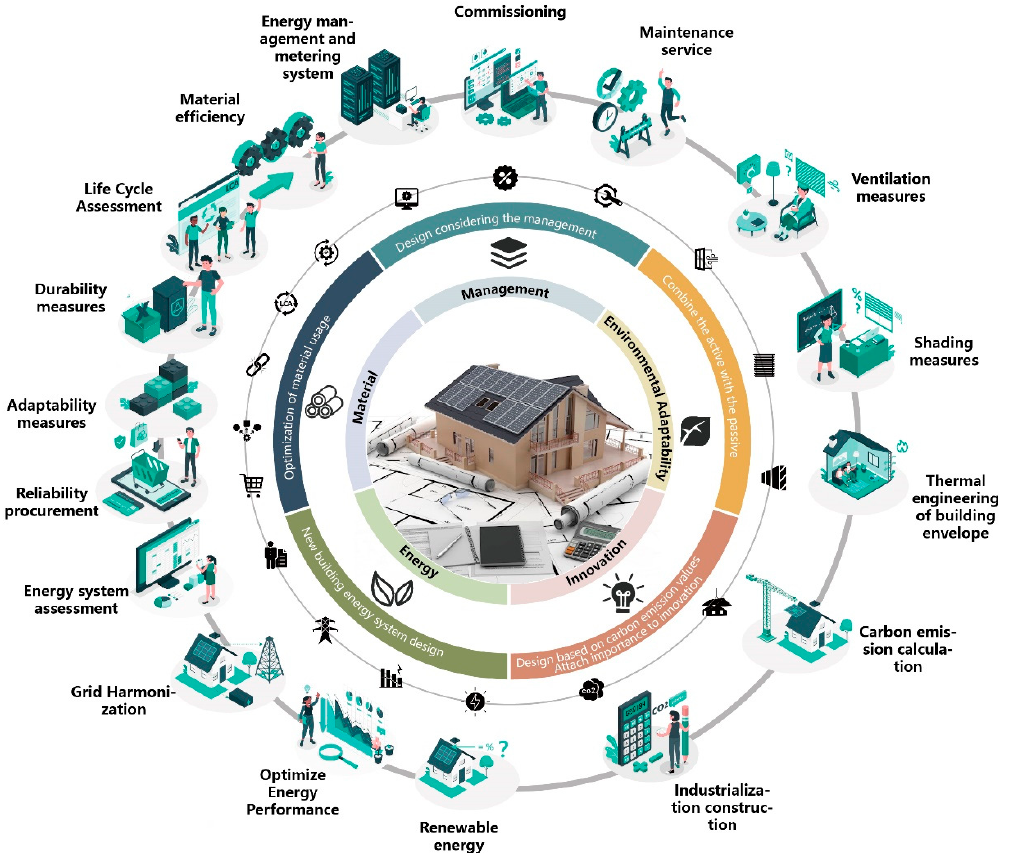
Figure 6. The low-carbon design path of BIPV.